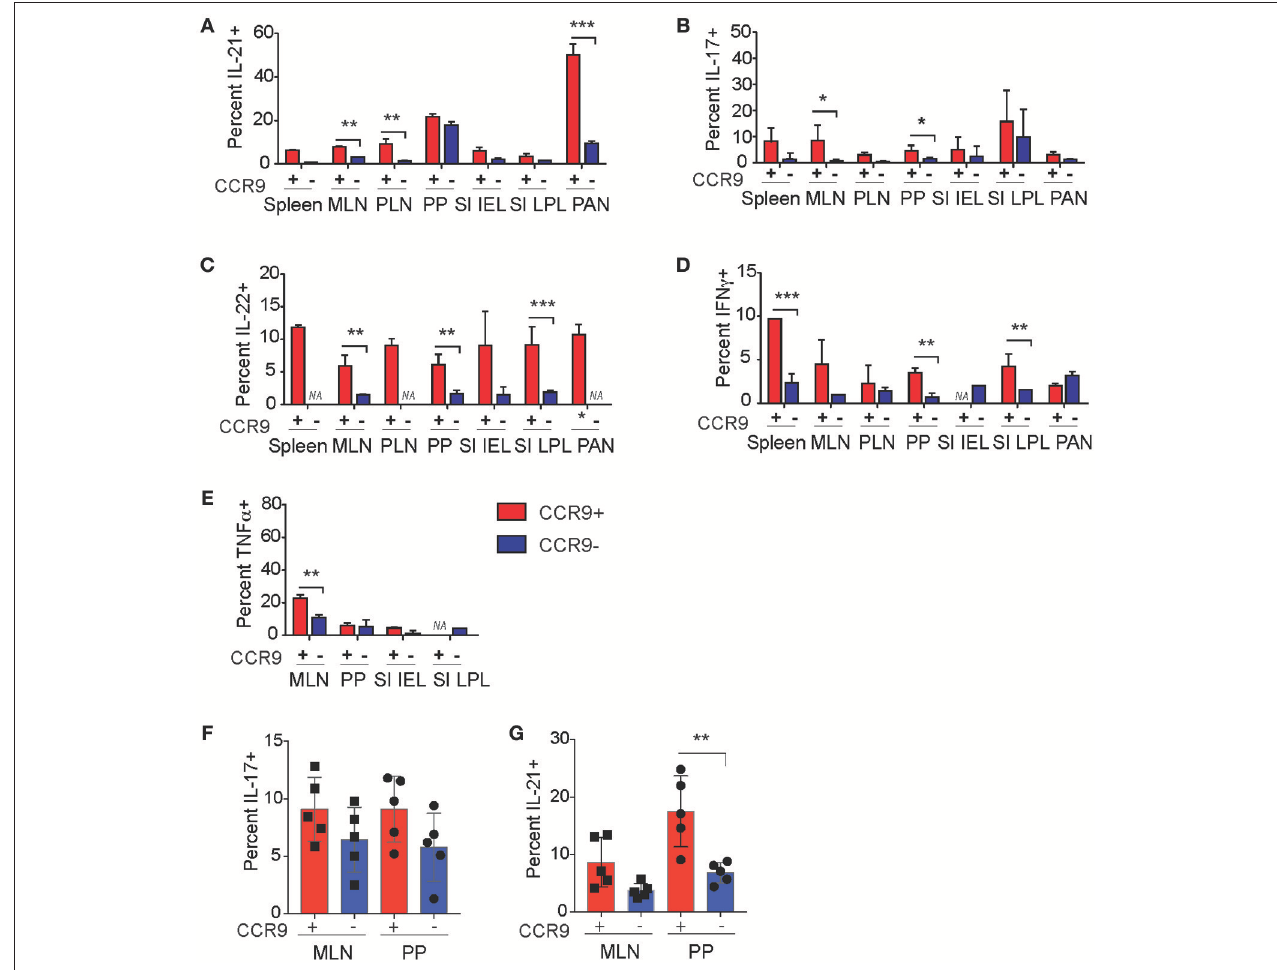
FIGURE 7 | CCR9 marks populations of Th and Tfh cells with enhanced cytokine expression in autoimmune inflammation . Percentages of cytokine expressing CCR9 + and CCR9 − CD4 + T helper (Th) and T follicular helper (Tfh) cells in the GIT and inflamed pancreas of NOD mice. CCR9 + and CCR9 − Th cells that contain (A) IL-21, (B) IL-17, (C) IL-22, (D) IFN γ , and (E) TNF α in the spleen. MLN, mesenteric lymph nodes; PP Peyer’s Patches; SI IEL, intraepithelial lymphocytes of the small intestine; SI LPL, lamina propria lymphocytes of the small intestine; LI IEL, intraepithelial lymphocytes of the large intestine; LI LPL, lamina propria lymphocytes of NOD mice. Percentages of (F) IL-17 and (G) IL-21 expressing CCR9 + and CCR9 − Tfh cells in the mesenteric lymph nodes (MLN) and Peyers patches (PP) of NOD mice. Cytokines were detected by intracellualr immunostaining and FACs analyses. Data is shown as mean ± SD from 3 experiments, female mice 11–12 weeks of age n = 5/group for Tfh cell analyses and n = 7/group for Th cell analyses. Statistical significance was assessed by 2-way ANOVA using Bonferroni’s multiple comparisons test. * P < 0.05; ** P < 0.01; *** P <